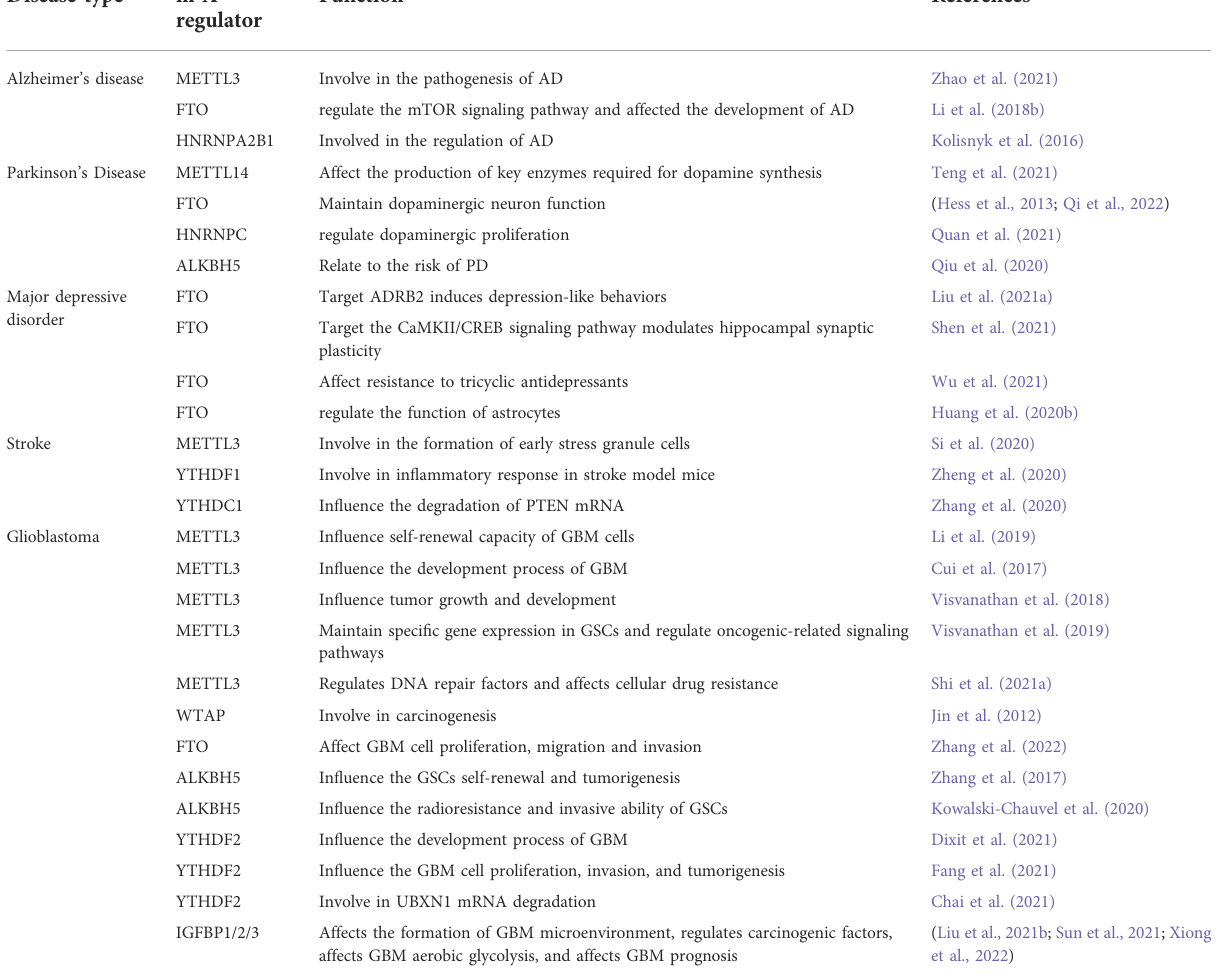
TABLE 2 Functions of m 6 A modi fi cation-related proteins in neurological